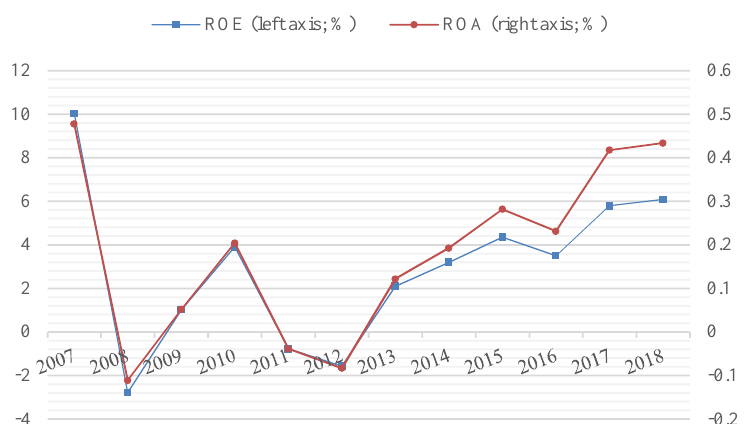
Figure 1. The development of profitability in banking sector in EU